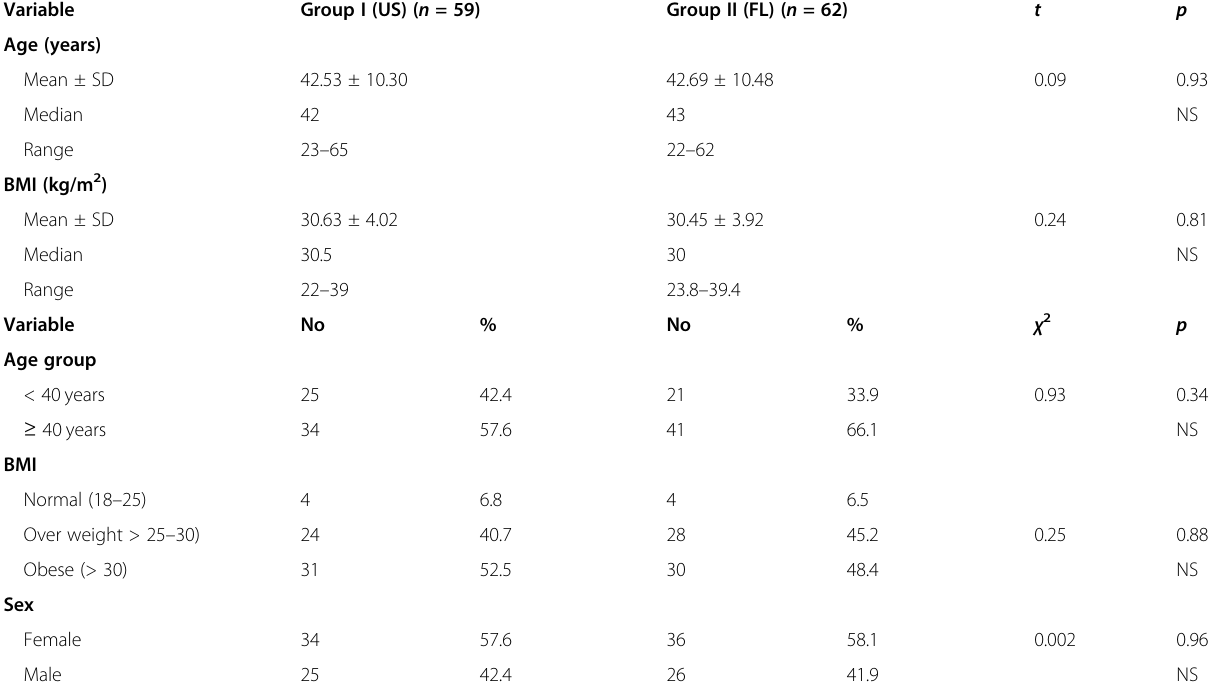
Table 1 Demographic data of the two studied groups